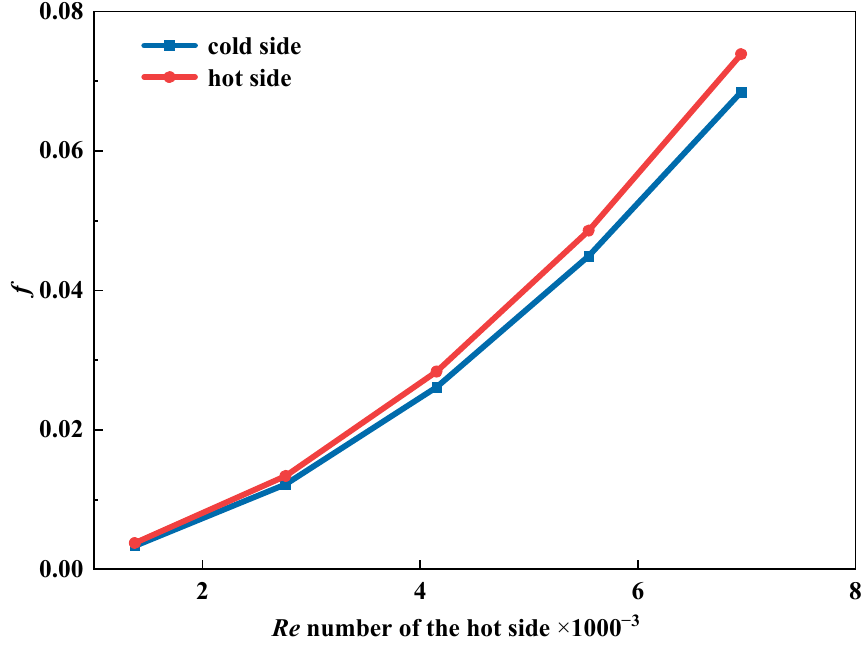
Figure 17. The relationship between the f factor and Reynolds number of the hot side.